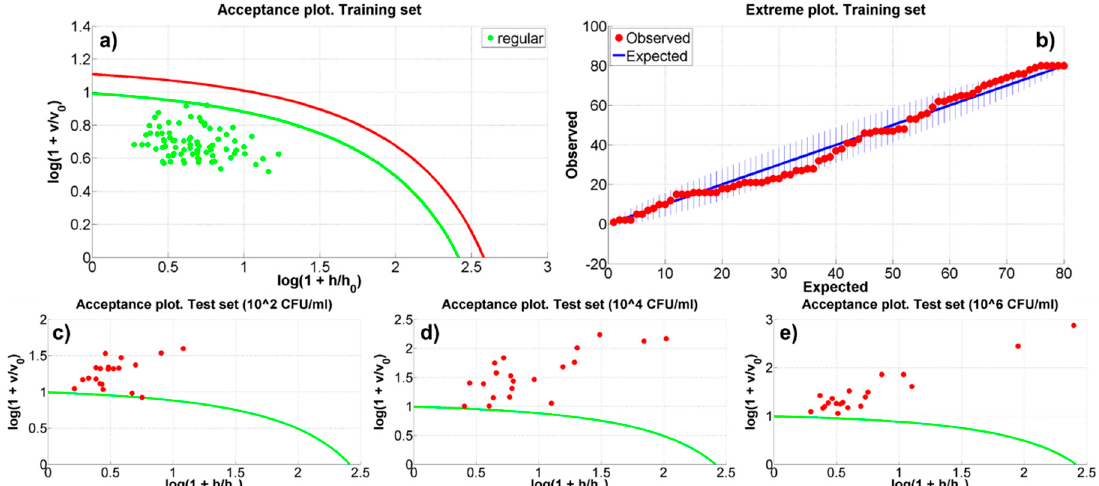
Figure 4 . The Data Driven Soft Independent Modeling of Class Analogy (DD-SIMCA) model results relative to the run number 9. Panel ( a ) shows the acceptance plot for the training set. Panel ( b ) shows the extreme plot for the training set (the number of observed extreme objects is within the tolerance area, the blue vertical lines). Panel ( c – e ) illustrate the acceptance plots for the BT-contaminated samples with 10 2 , 10 4 and 10 6 CFU/mL. In panels ( a , c–e ), h and v represents the score and orthogonal distance and h 0 and v 0 the mean score and orthogonal distance of the training set, respectively.